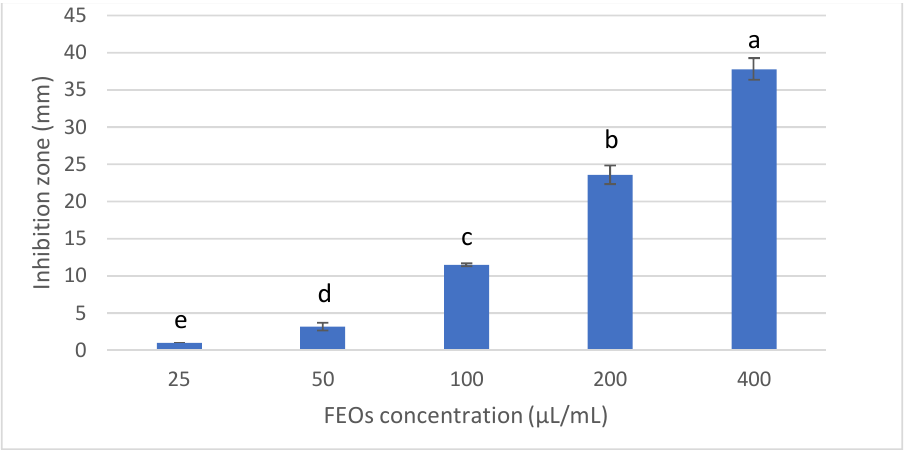
Figure 2. Antifungal activity of FSEO at different concentrations against F. solani . Data are expressed as means ± standard deviations in triplicate. Different alphabetic superscripts in the same column are significantly different ( p < 0.05) based on Tukey’s multiple comparison test.